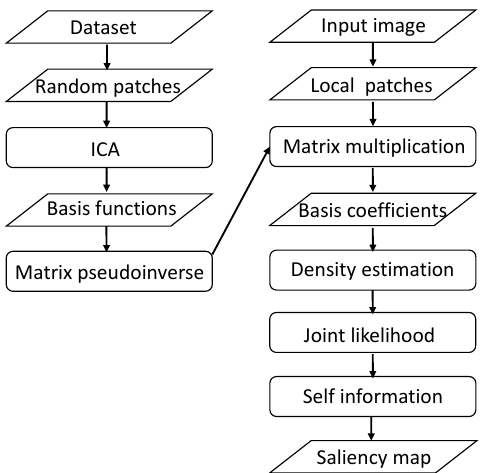
Figure 4. Flowchart of the attention by information maximization (AIM) saliency model.